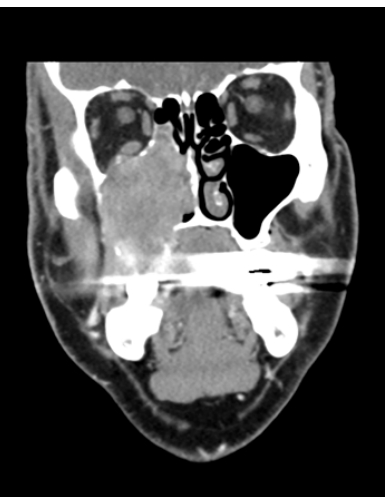
Figure 2. C oronal CT imaging demonstrates a solid nonhomogeneous tumour that completely fills the right maxillary sinus, destroying the medial and dorsolateral wall of the sinus and the base of the right orbit. The CT images are published with the permission of the Radiology Department, The Hospital of Č eské Bud ě jovice, Czech Republic.